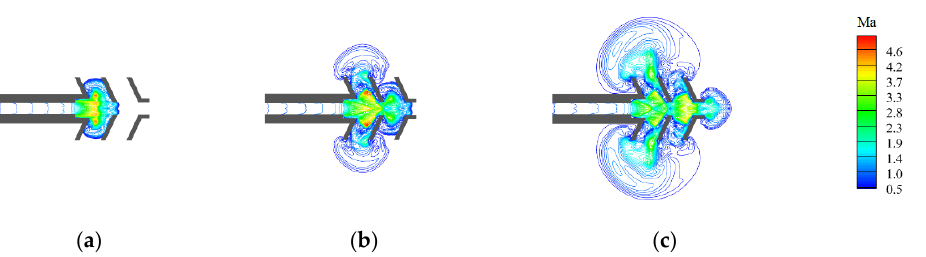
Figure 18. Distribution of Mach number in muzzle brake of type 2. ( a ) t = 0.05 ms. ( b ) t = 0.10 ms. ( c ) t = 0.20 ms.